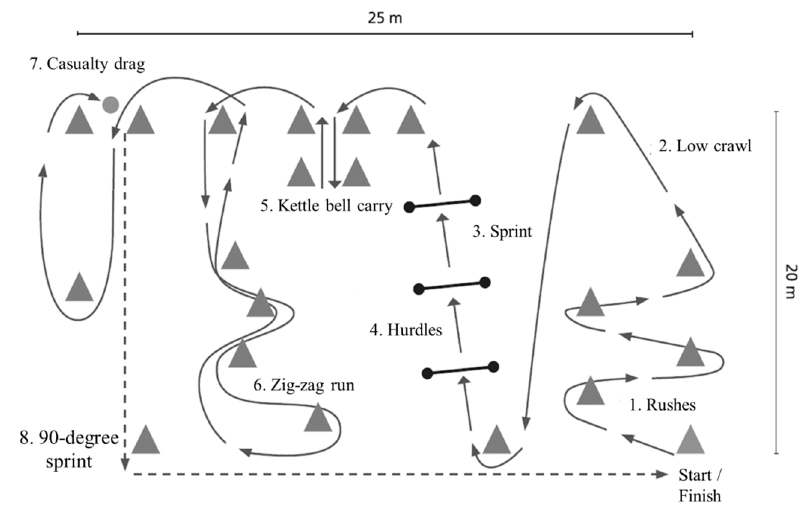
Figure 1. Illustration of the military simulation test track, including eight tasks (1–8) of the test.